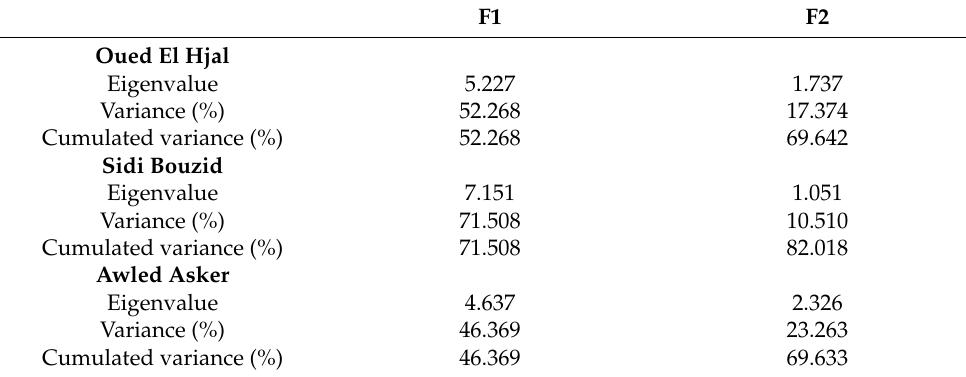
Table 1. The contribution of the factorial axes in the total values and the attributed eigenvalues of groundwater in the three sub-basins of the study